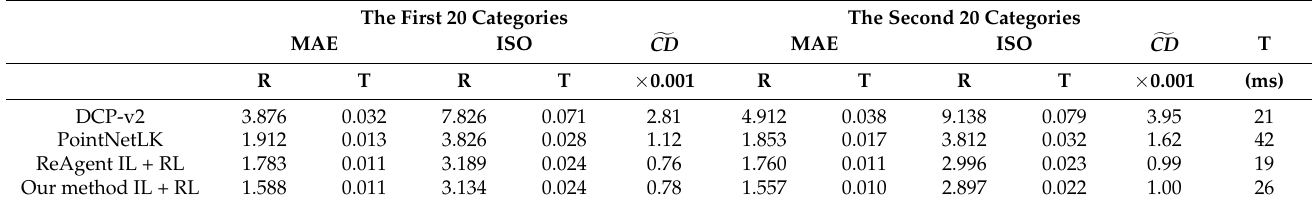
Table 1. Registration Results on ModelNet40.